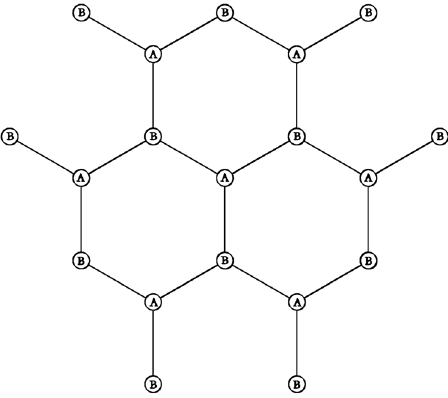
Figure 2: The atomic structure of BNNTs by replacing carbon atoms of CNT by boron and nitrogen atoms.